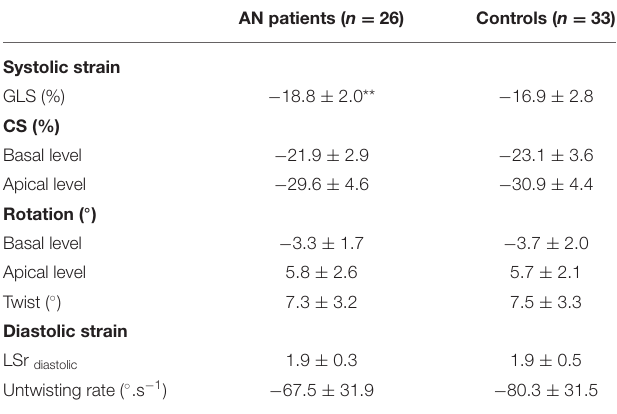
TABLE 3 | Left ventricular strains and twisting mechanics in AN patients and controls.